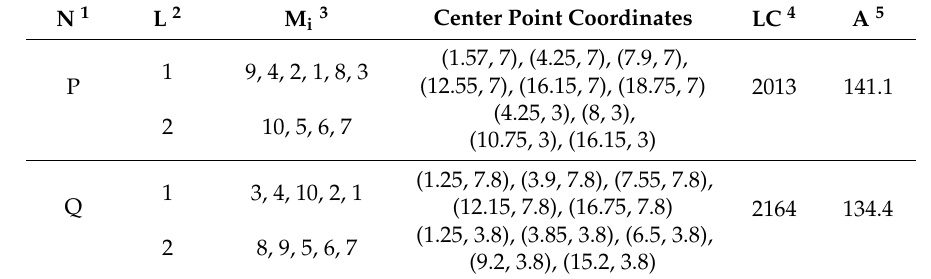
Table 9. Display of partial plans.